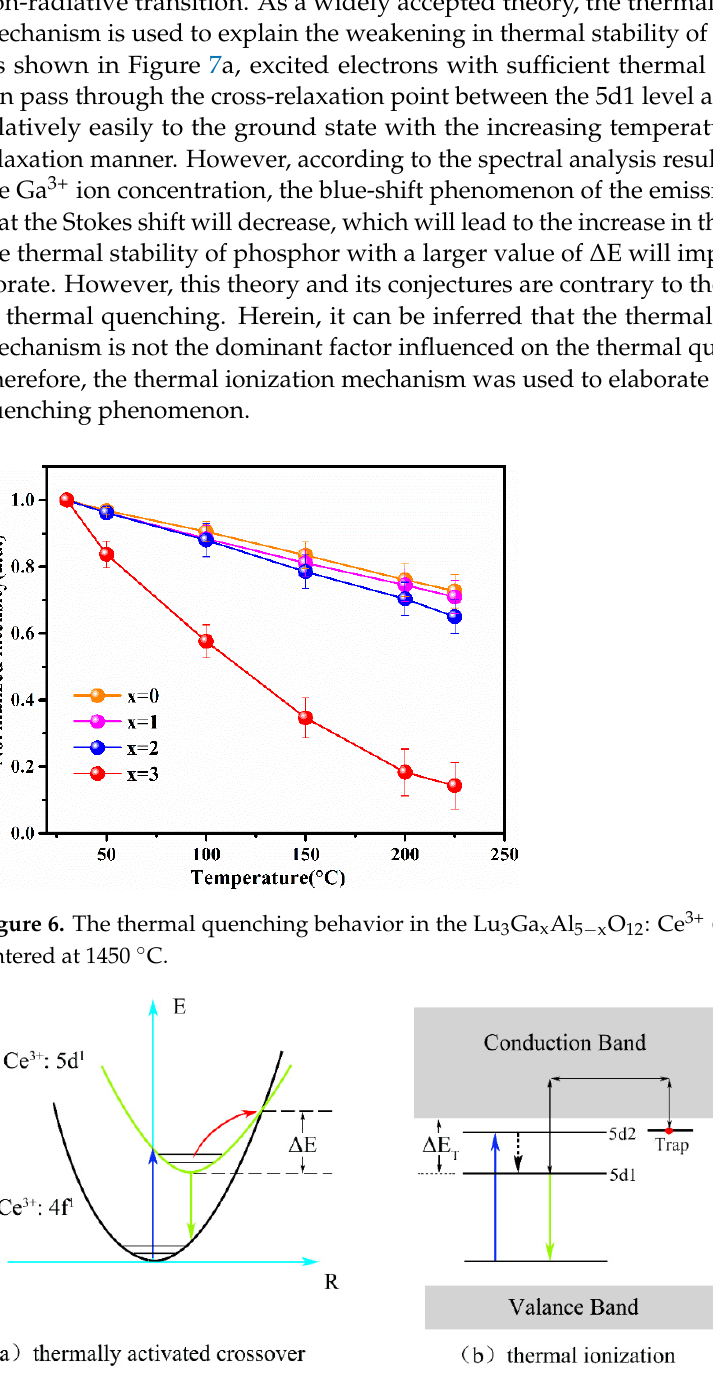
Figure 7. ( a ) The thermally activated crossover and ( b ) thermal ionization model for the thermal